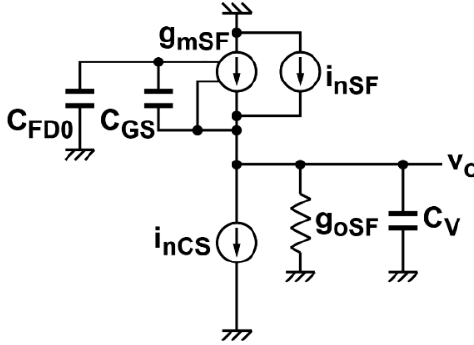
Figure 5. Equivalent circuit of the pixel source follower for noise analysis.